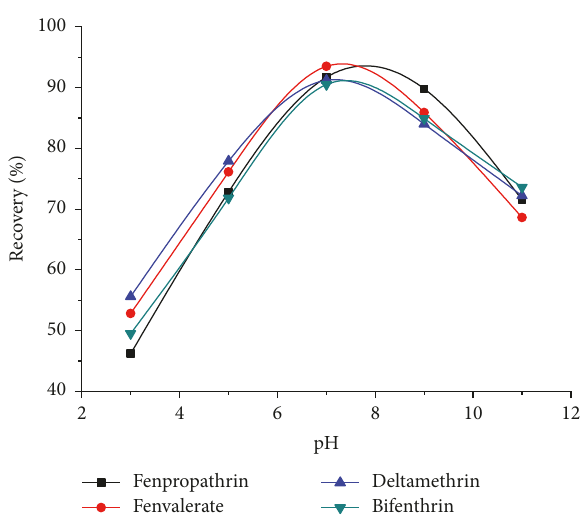
Figure6:Effectofultrasonicationtime.Extractionconditions:sam- ple volume, 50.0 mL spiked with 100 ng mL −1 of four pyrethroids; pH, 7.0; magnetic nanoparticles (MNPs), 60 mg; eluent solvent, 2 mL of acetonitrile/acetic acid (9:1,